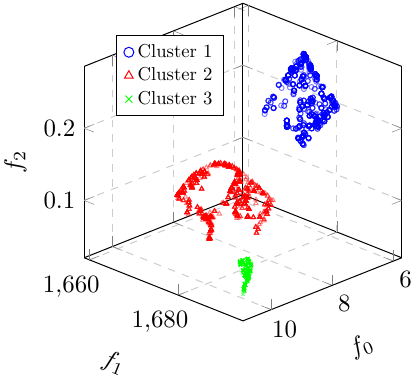
Figure 1. Non-dominated solutions from RE3-5-4. Table 1. Rule interactions found by using FPM for each of the clusters shown in Figure 1. Cluster Rule